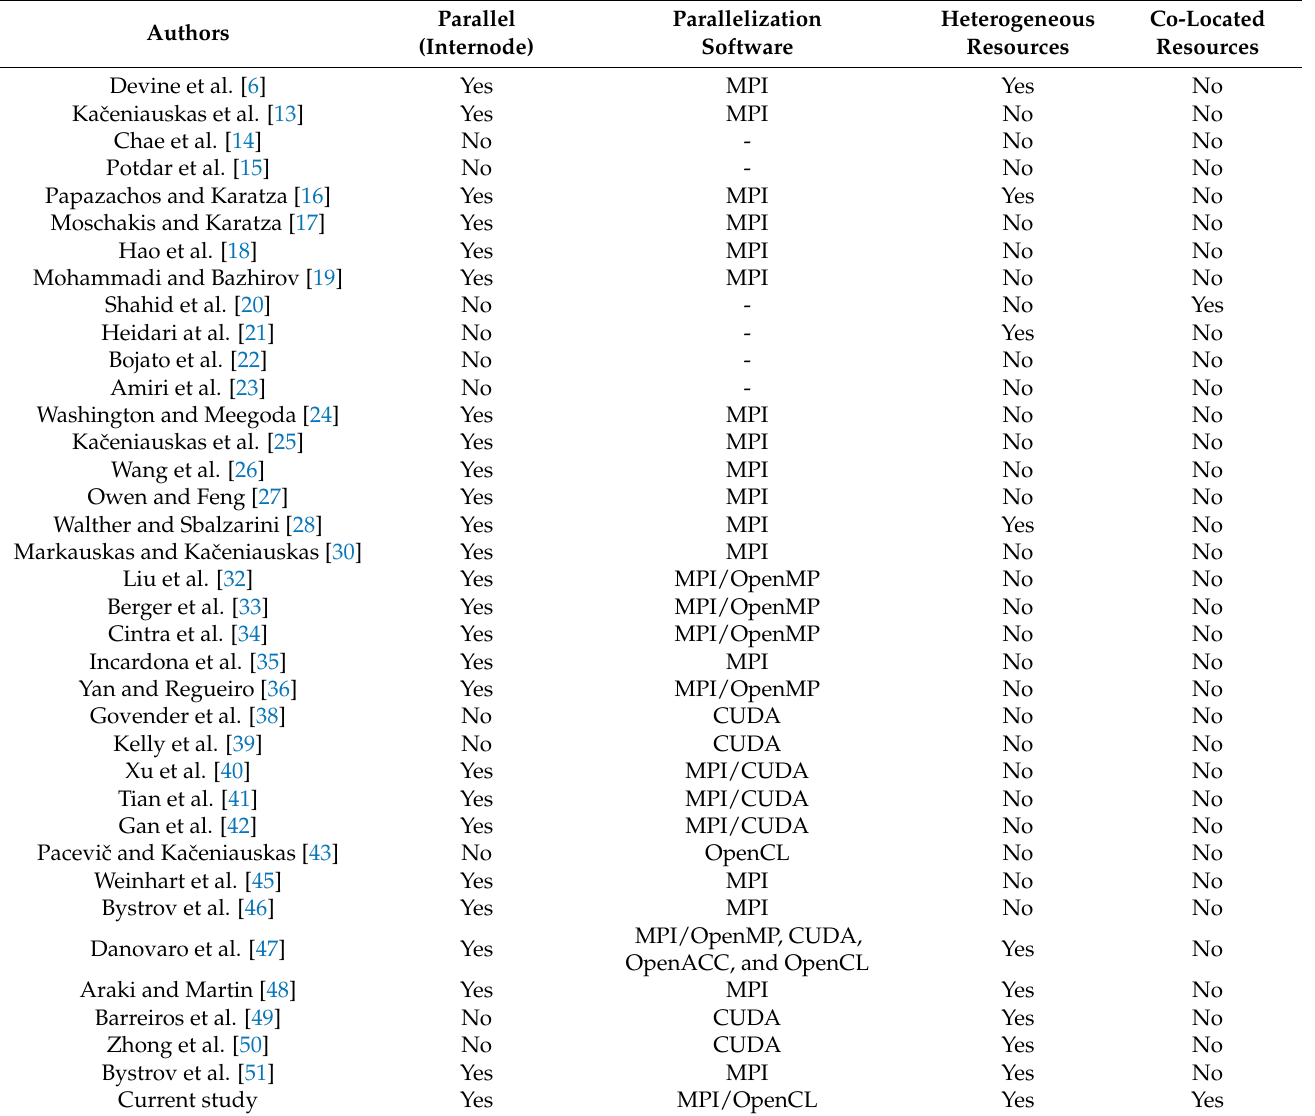
Table 1. Comparison of the related